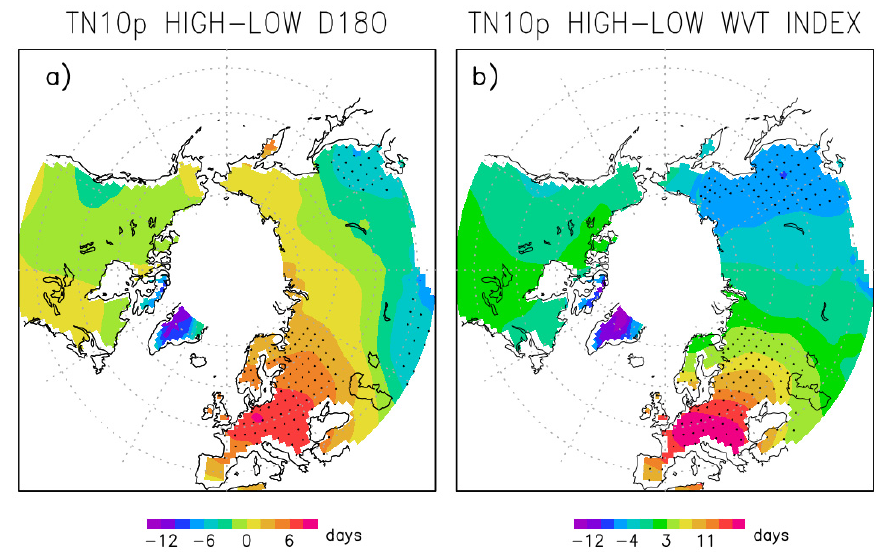
Figure 8. ( a ) The difference between composite maps of frequency of cold nights (TN10p) associated with high and, respectively, low ice core δ 18 O winters ( b ), as in ( a ), but for extreme WVT index (see text for definition). Regions where the differences are significant at the 90% level are dotted. Units: days.